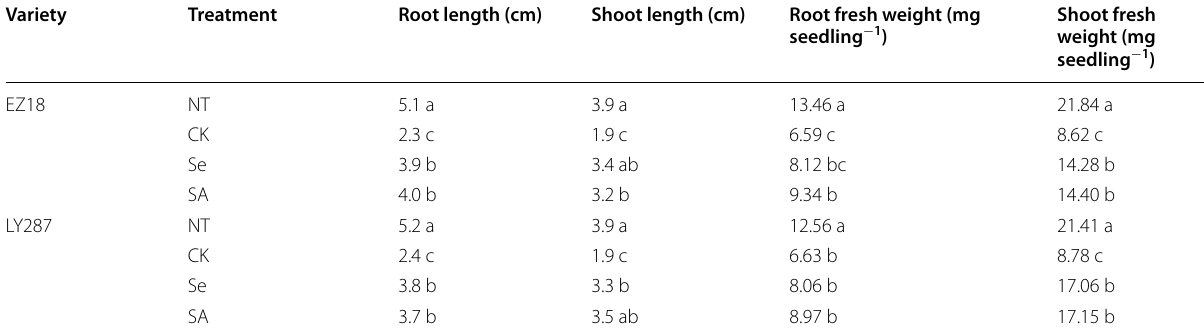
Within a column for each variety, different lowercase letters denote statistical differences at the 5% level according to LSD test. EZ18, ezao18; LY287, liangyou287; NT, no priming-normal temperature control; CK, no priming-chilling stress; Se, Selenium priming-chilling stress; SA, Salicylic priming-chilling stress